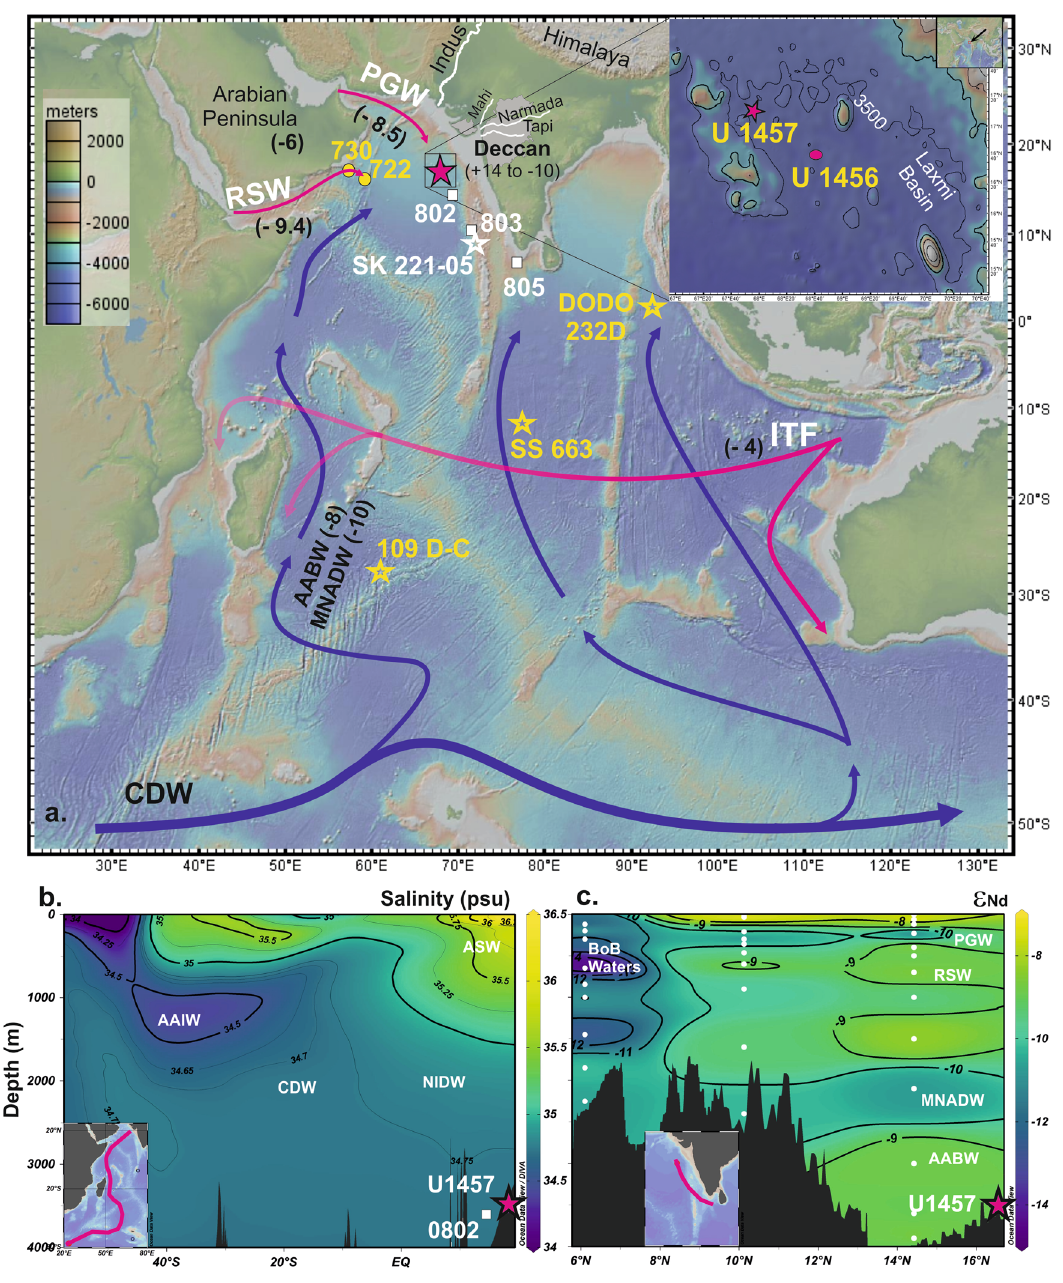
Fig. 1 | Study Area and location of authigenic ε Nd records. a Location map with the water mass pathways and their characteristics ε Nd values. The pink star repre- sents core site (U1457) of the present study. The white square represents the proximal seawater stations 0802, 0803 and 0805 in the Arabian Sea 17 . The white starmarksthelocationofsedimentcoresiteSK221-05 16 usedforreconstructionof authigenic ε Nd records in the Arabian Sea. Yellow star marks Fe-Mn crust sites DODO 232D 11 , 109 D-C and SS 663 12 from the Indian Ocean. Yellow circle along the Oman coast marks the core site used for the paleo-monsoon reconstructions. Surface water masses are marked by pink lines and blue lines indicate deep water masses. The image in the inset shows the high-resolution bathymetry of the core